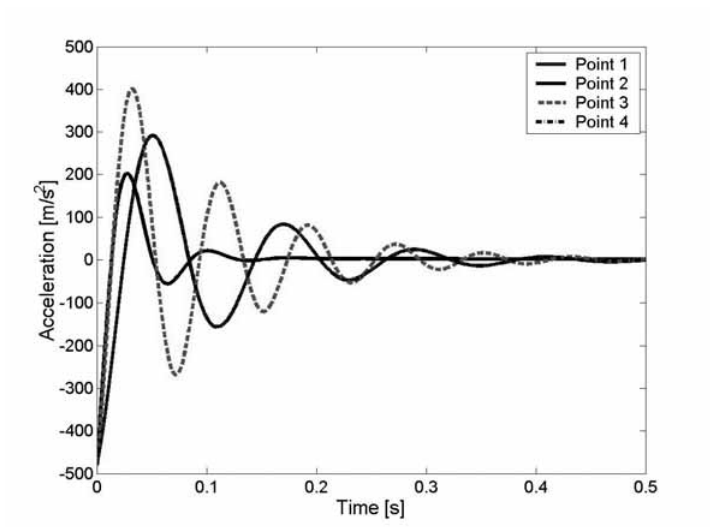
Fig. 32. Optimized engine mass acceleration transient